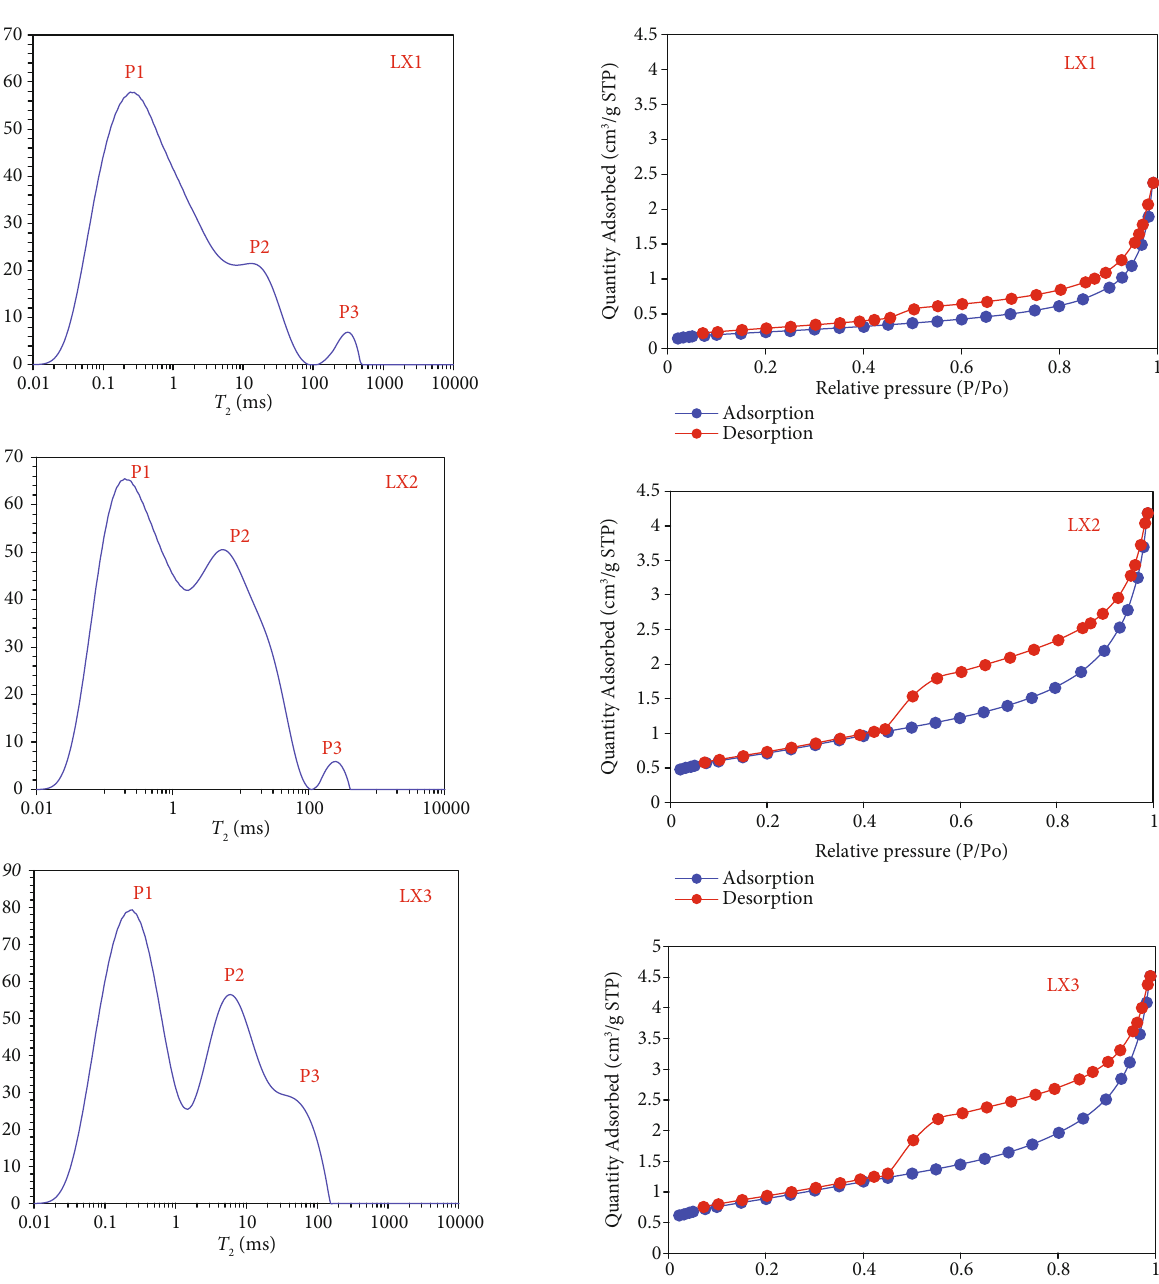
distributions of the three water-saturated 2